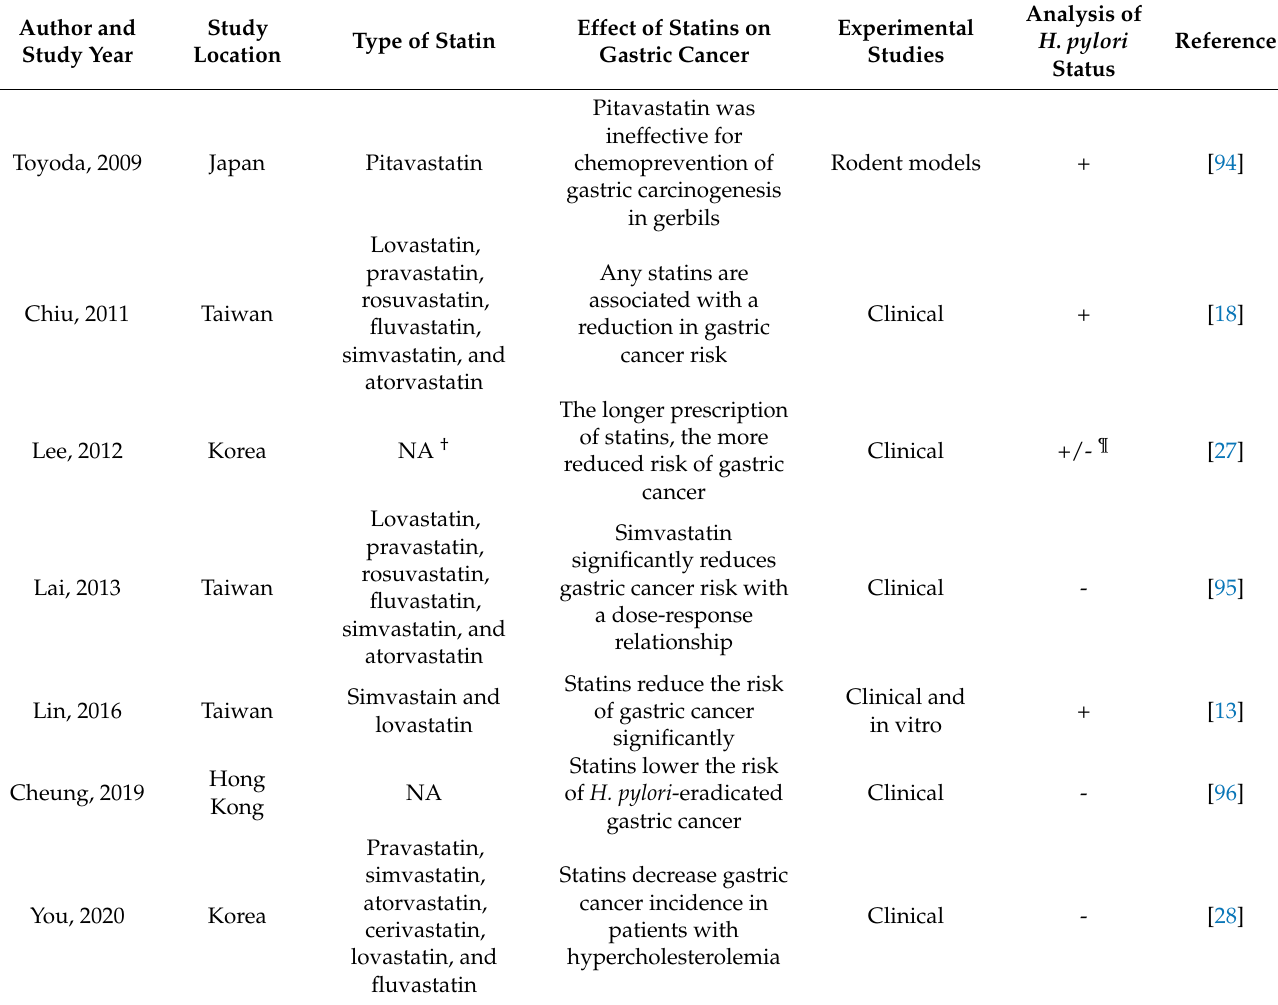
Table 1. The effects of statins on GC